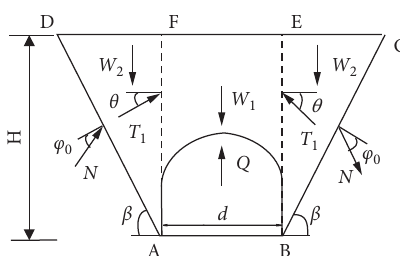
Figure 2: Model of surrounding rock pressure of shallow buried